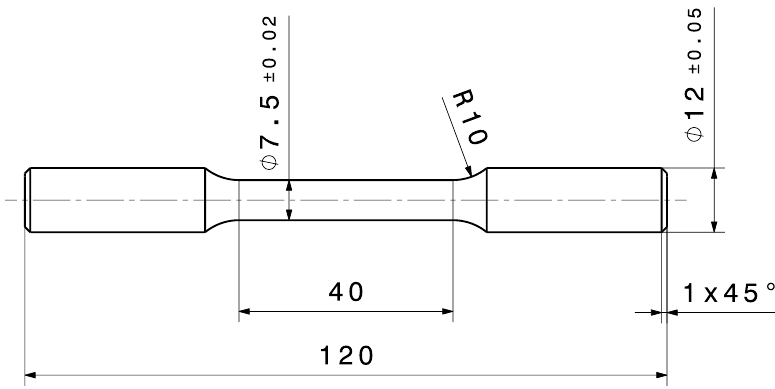
Figure 3. Geometry of the tensile test